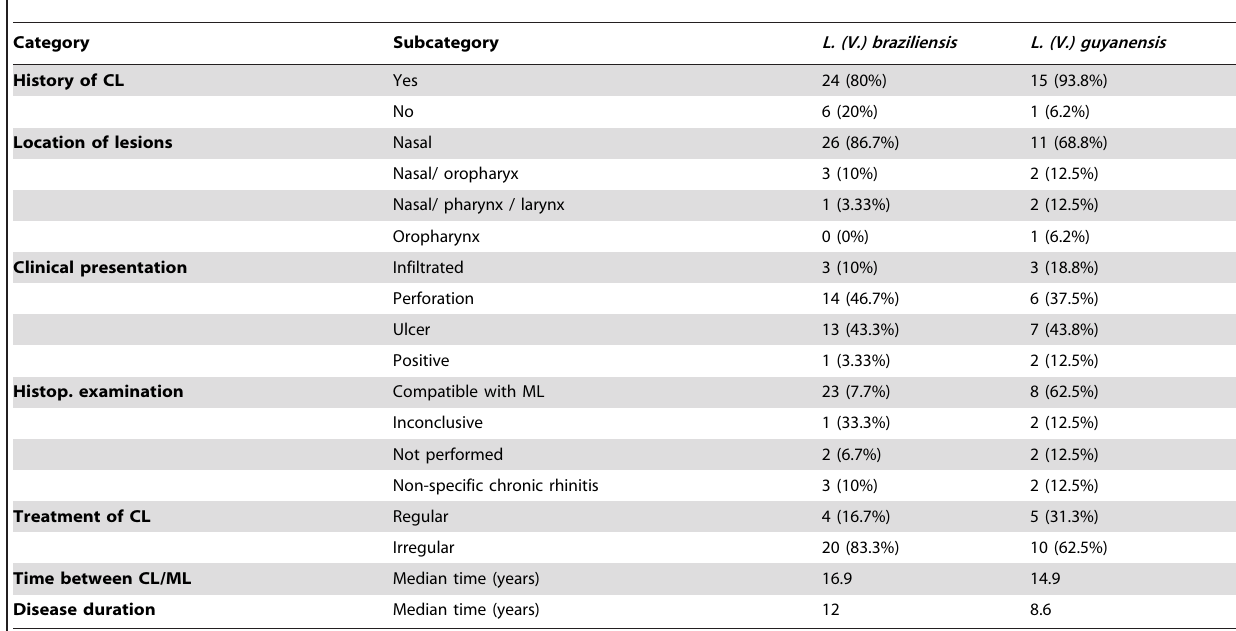
Table 1. Clinical and epidemiological aspects of cases according to the species